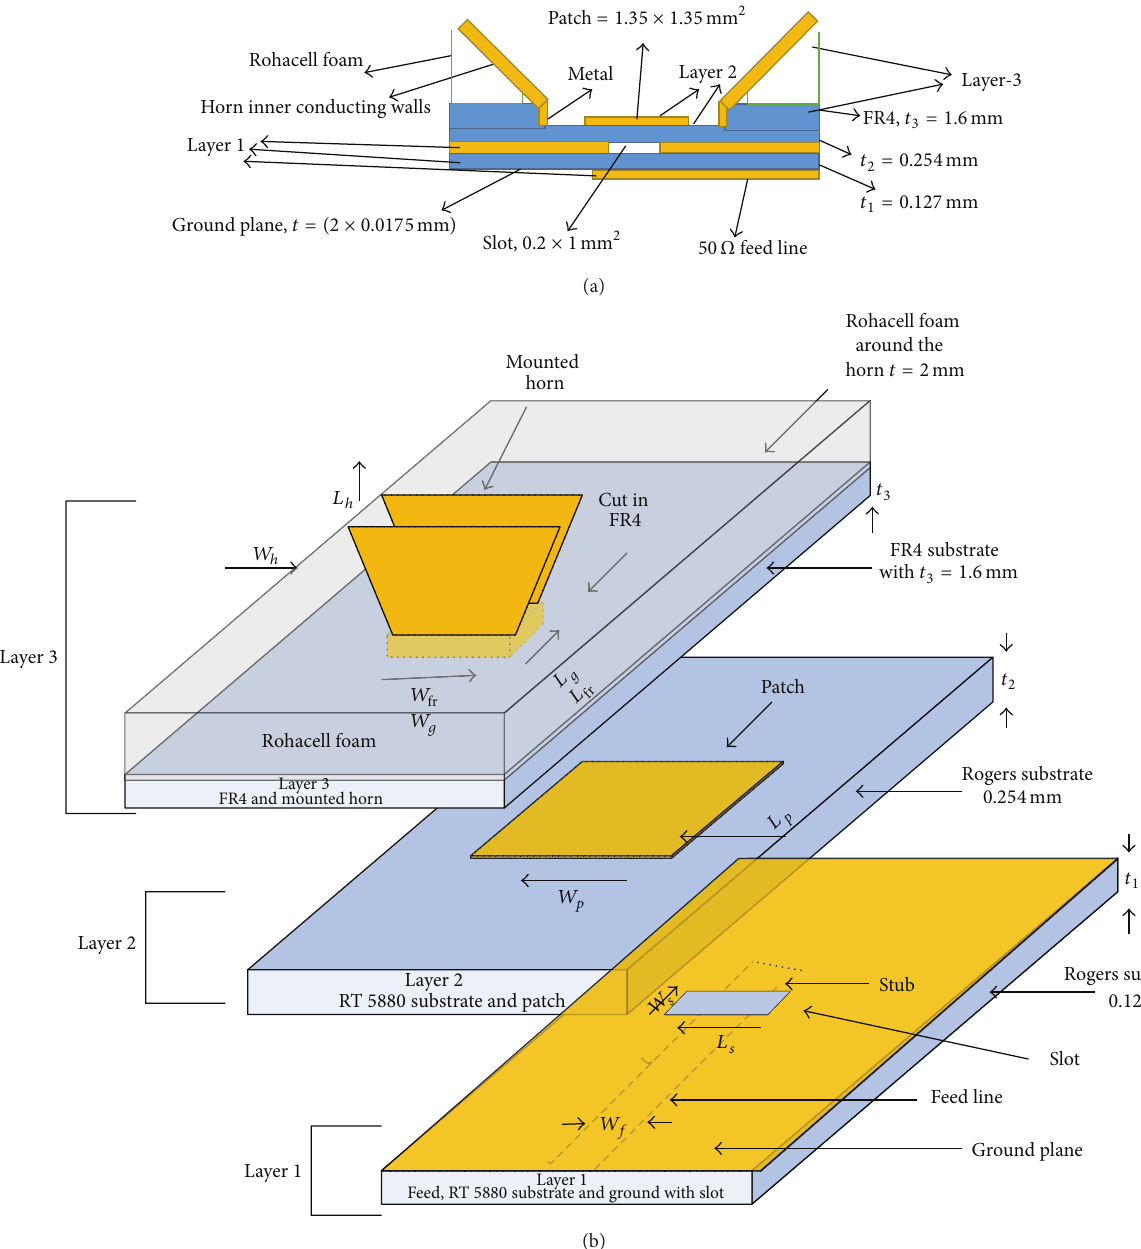
Figure 1: (a) Cutting Plane of a multilayer ACMPA with mounted Horn on FR4. (b) Exploded view of the proposed antenna.